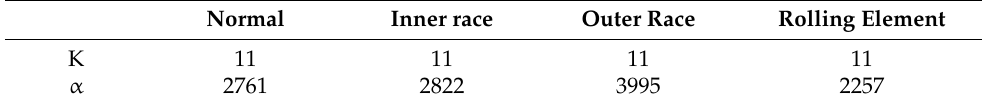
Table 2. Optimization parameters obtained by using the ISSA.